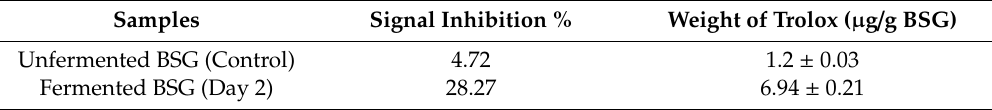
Table 3. Trolox quantification for antioxidant activity before and after